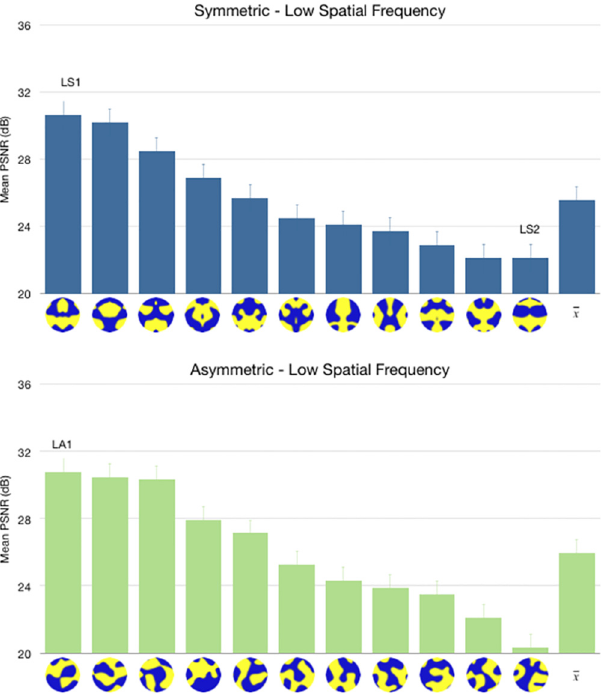
Fig 4. PSNR reconstruction values for low spatial frequency symmetric and asymmetric patterns. Test patterns are ordered from best PSNR values to worst PSNR values, and the last bar shows the mean PSNR value for all test patterns of the same category. Results are based on 300 simulations. Error bars show 95% confidence interval. The patterns labelled “ LS1 ” and “ LA1 ” were used in a behavioural experiment testing the predictions of this model, reported in